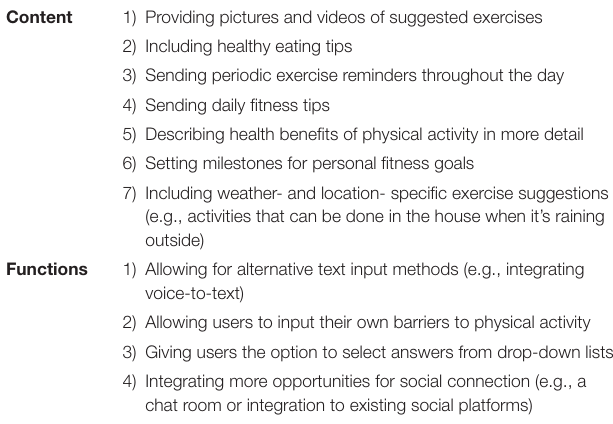
TABLE 2 | Specific recommendations for content and